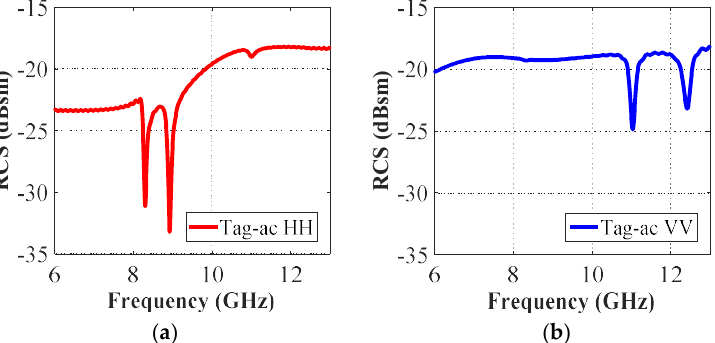
Figure 7. Co-polar RCS simulation results of tag-ac: ( a ) Co-polar HH RCS responses; ( b ) Co-polar VV RCS responses.